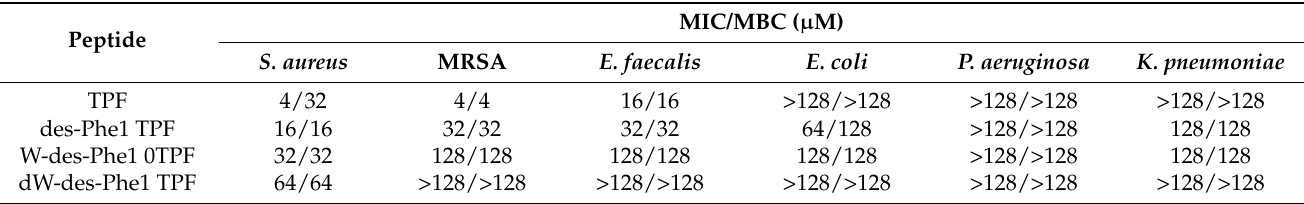
Table 3. The minimal inhibitory concentrations (MIC) and minimal bactericide concentrations (MBC) of Temporin-PF and the synthetic analog peptides against selected microorganisms.